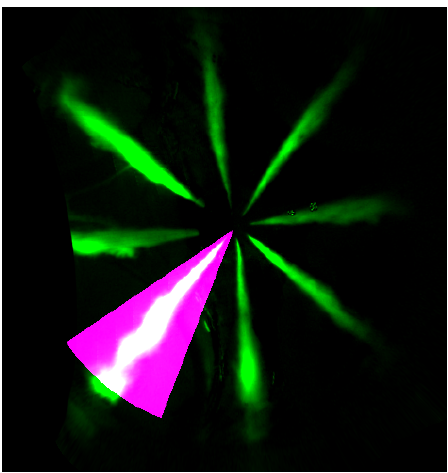
Figure A5. Averaged intensity single from the sampling of a series of circular masks, to find the strongest scattering spray and its angular position.